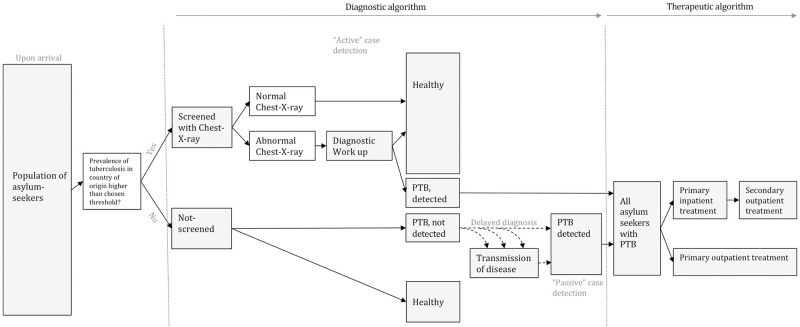
Decision tree of the screening process.PTB = Pulmonary tuberculosis. Asylum-seekers either undergo screening for tuberculosis by chest X-ray or are not screened based on a range of hypothetically chosen thresholds derived from the TB incidence per 100,000 population in their country of origin. Chest X-rays suggestive of tuberculosis are followed up by a clinical examination, microscopy and culture. If an asylum-seeker is diagnosed with pulmonary tuberculosis, they then start treatment. All asylum-seekers with prevalent tuberculosis who are not detected through screening are assumed to become symptomatic and be detected “passively”.